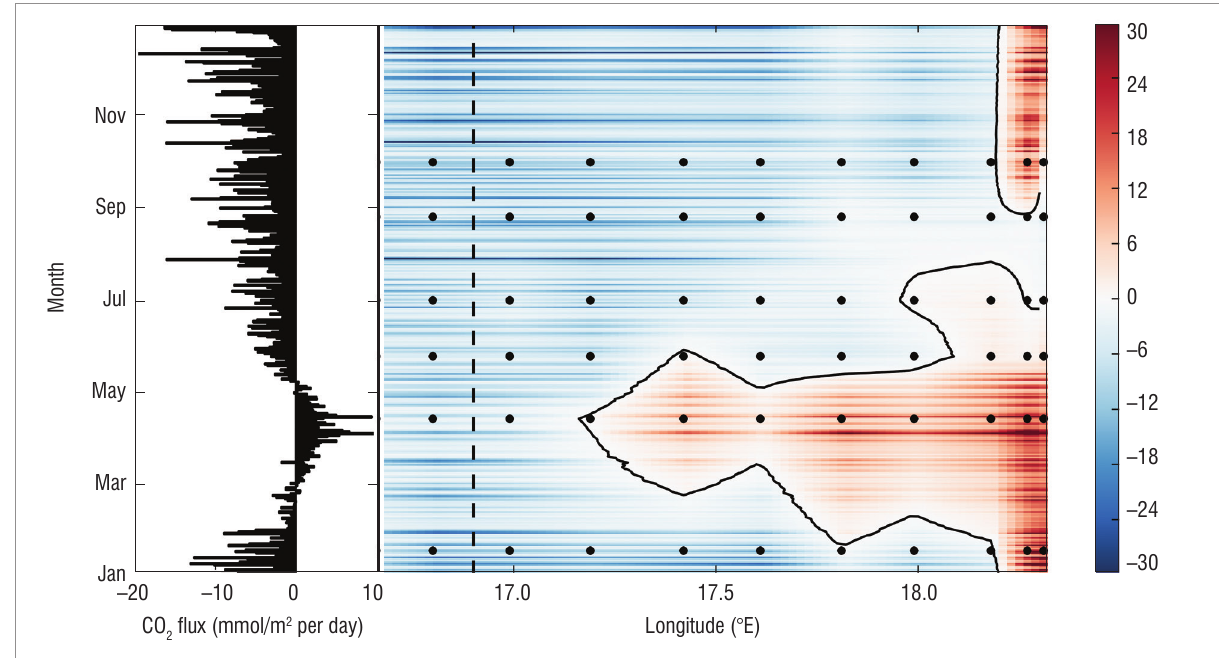
flux (mmol/m 2 per day) along the St. Helena Bay Monitoring line for daily winds (right). Red is outgassing and blue is ingassing. The dot Figure 2: CO 2 markers show the sample location and date and the dashed line shows the approximate location of sampling by González-Dávila et al. 13 The average daily flux is plotted on the